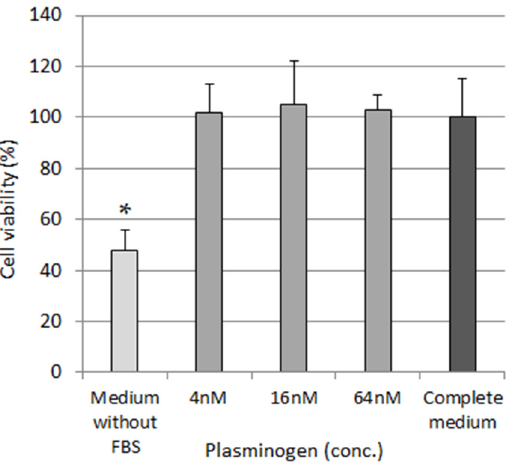
Figure 1. Cytotoxic effects of various Plg concentrations on L929 cells. * p ˂ 0.05 vs all